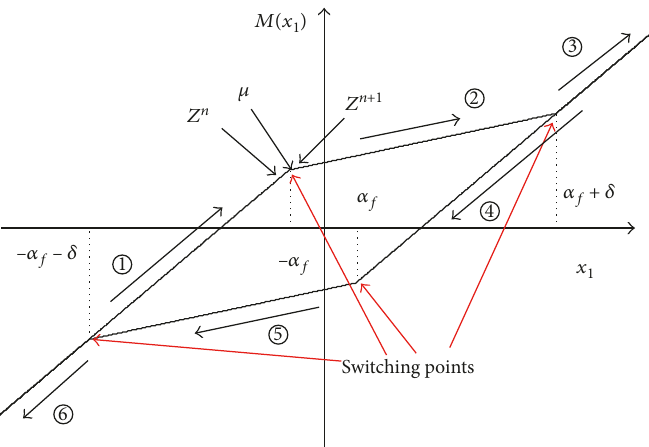
Figure 2: A hysteresis nonlinearity and illustration of the predictor-corrector algorithm for fi nding exact switching